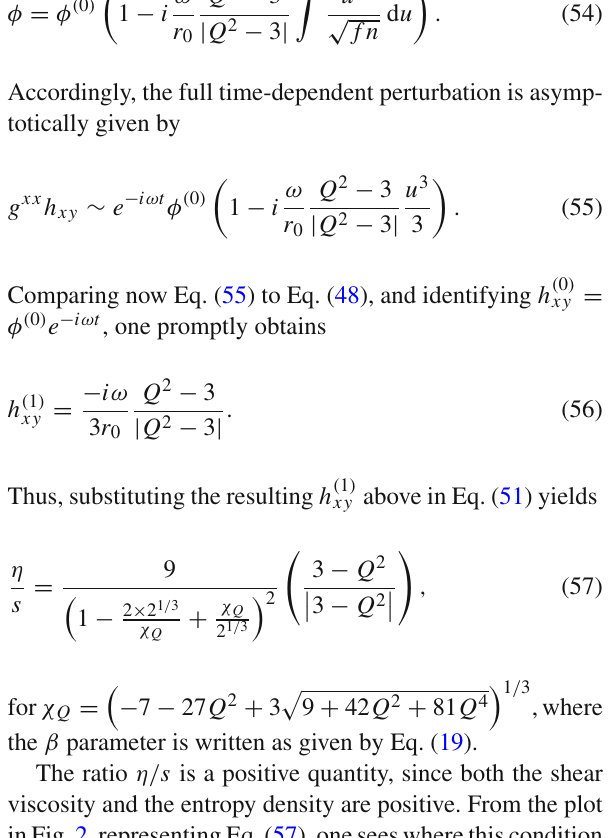
. We see that there is a √ 4 π